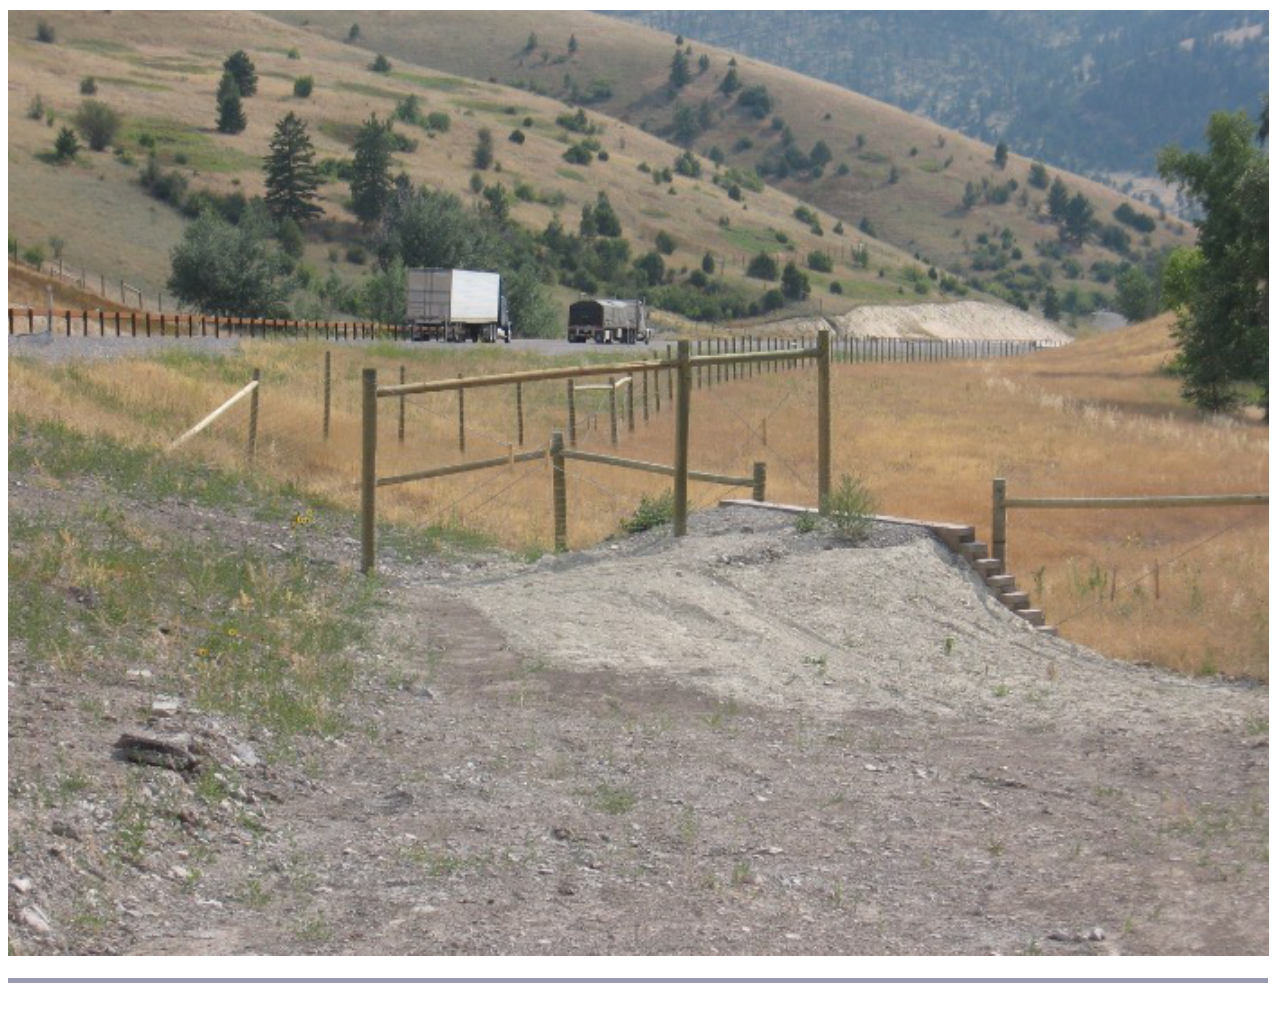
Fig. 3. A short section of perpendicular fence to guide animals on top of a jump-out along a 2.4 m (8 ft) high fence along U.S. Highway 93 on the Flathead Reservation, Montana, USA (copyright: Marcel